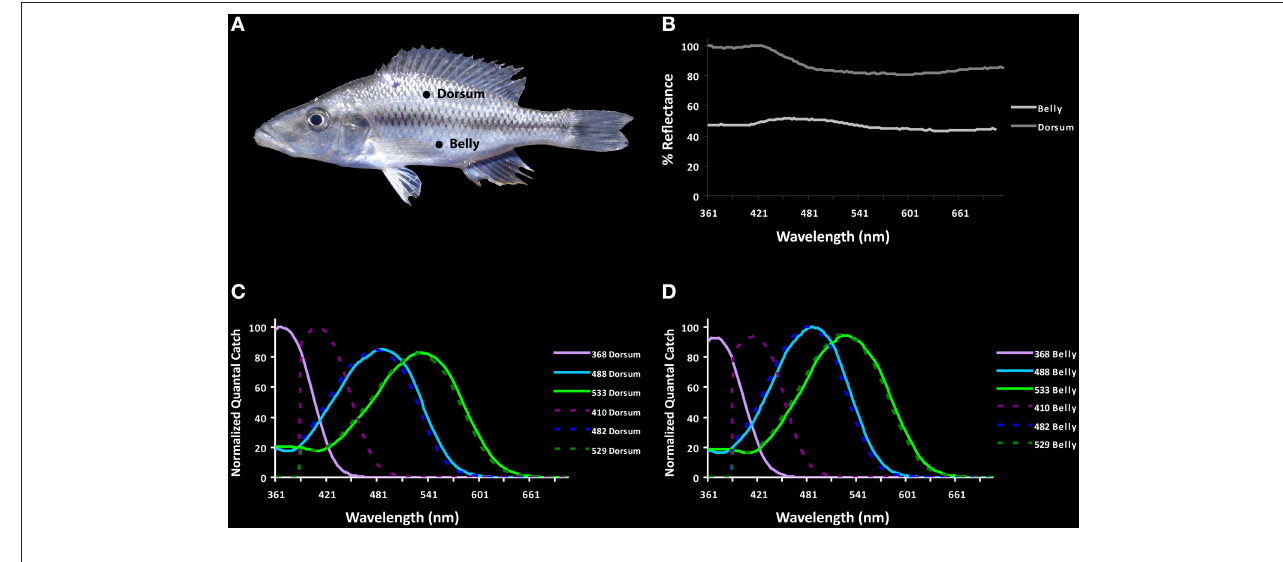
FIGURE 8 | Dimidiochromis compressiceps .